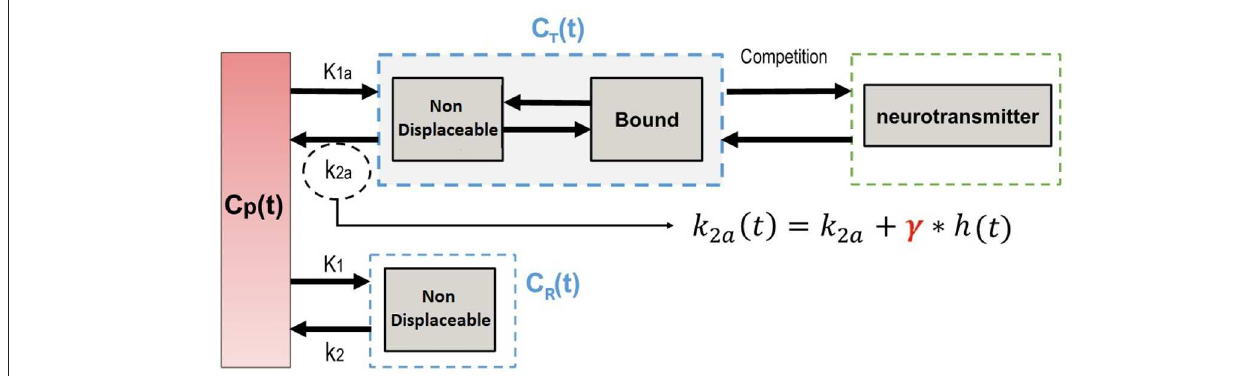
FIGURE 1 | Compartment model illustrating a competition model.